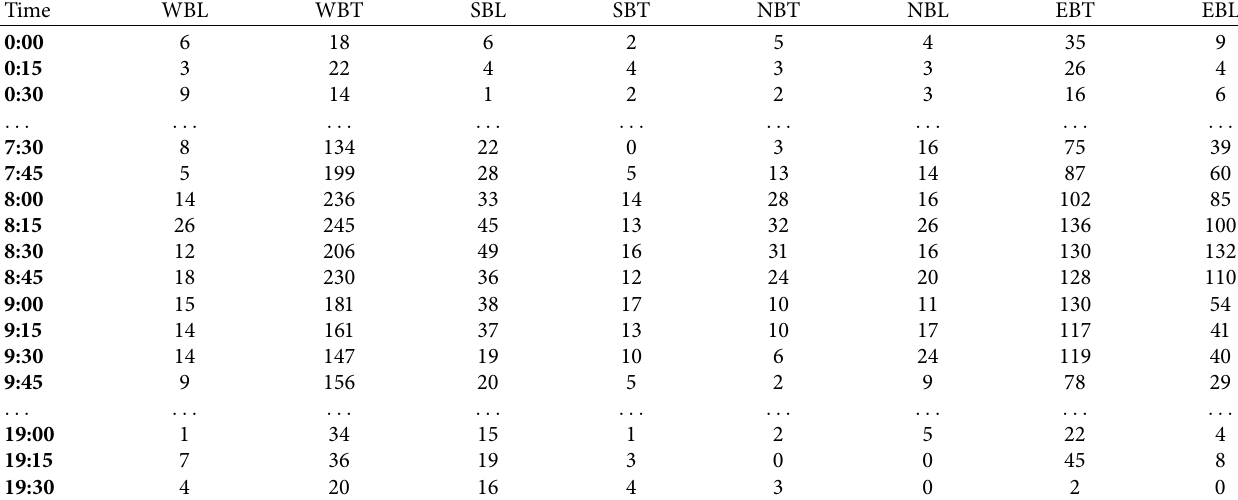
Table 6: Traffic flow (pcu/15 minutes).